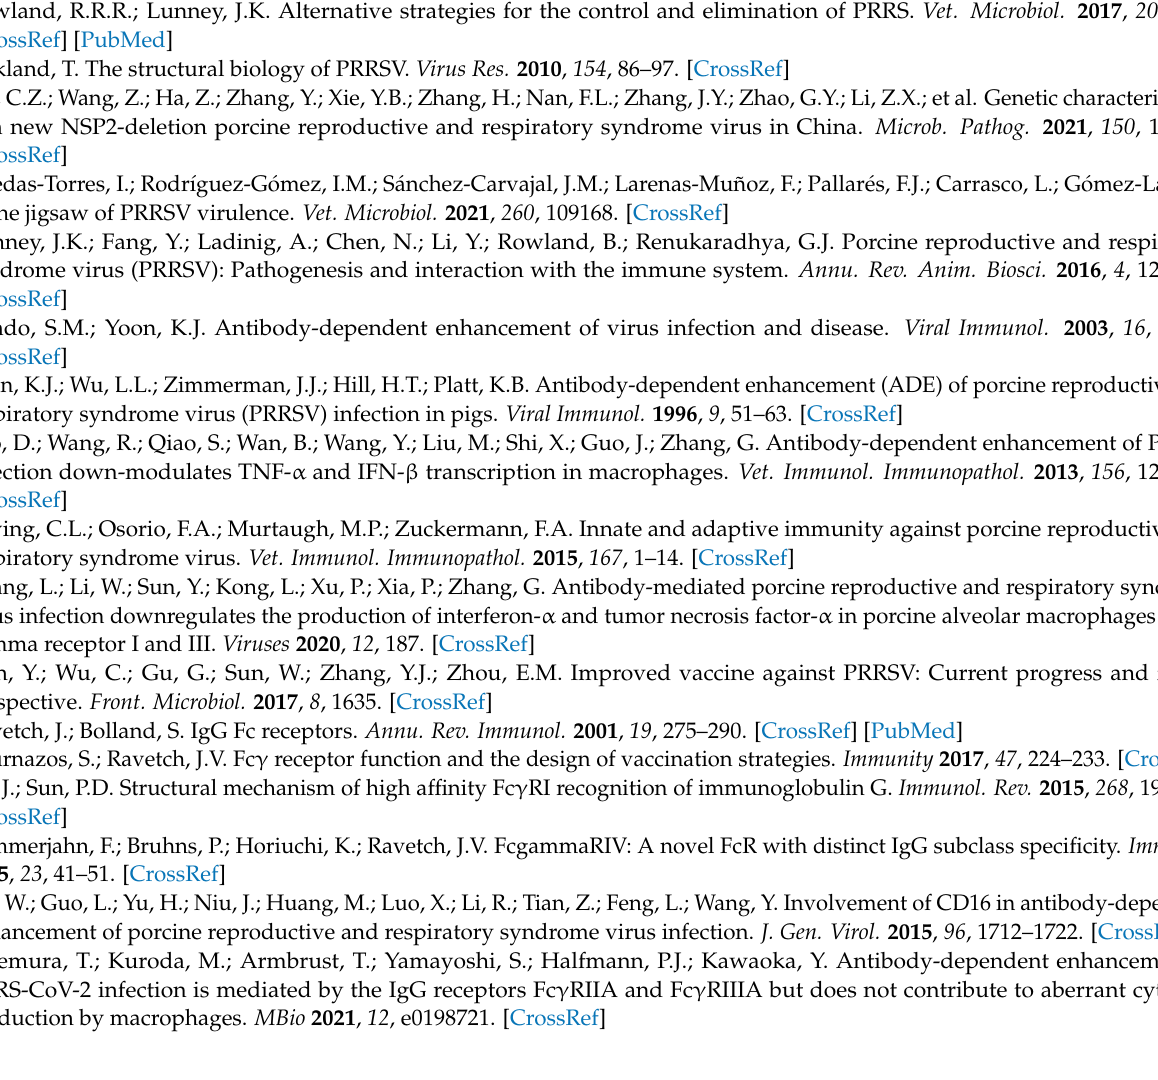
Figure S2FCR3-48H-2018.08.20_08.03.12_Ch+Marker; FigureS3gapdh-48h2019.04.02_08.01.16_Ch+Marker; Figure S4 gapdh-fc3-48h-3